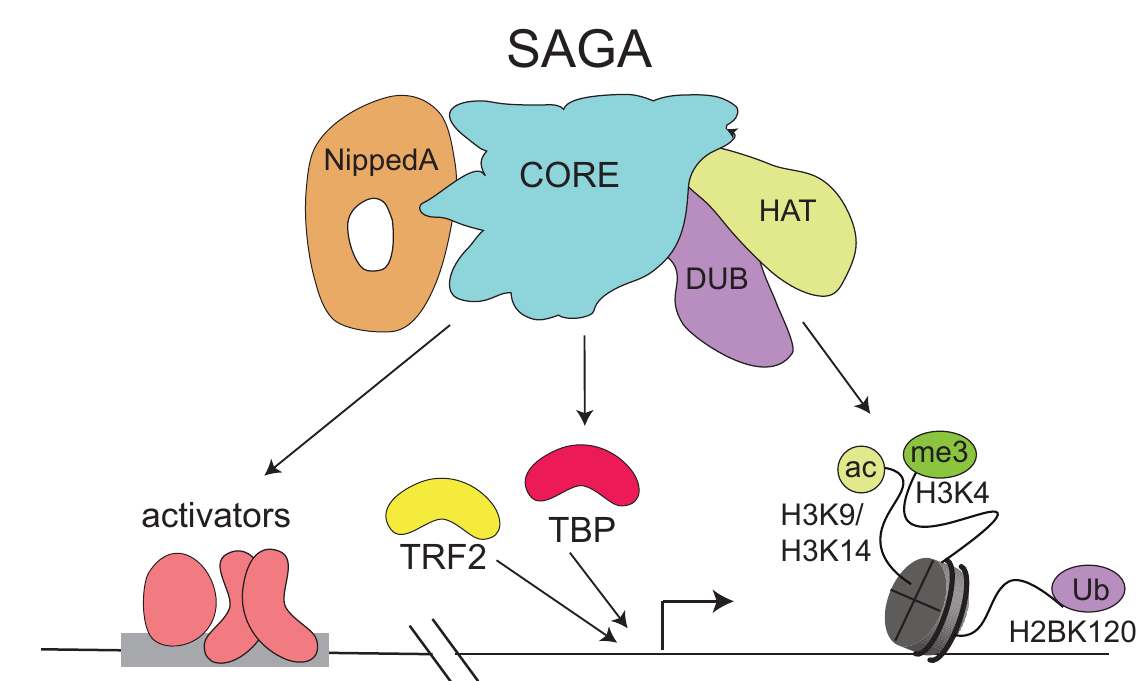
Fig 7. Cartoon of SAGA core module functions during oogenesis. The SAGA complex binds upstream and downstream of the TSS at active genes, without discriminating by promoter type. The upstream peak is likely due to interactions of the core module and Nipped A, which interact with activators. The complex is also present at the +1 nucleosome, where it can read H2bUb, H3K4me3 and H3K9/4ac and is retained. After its recruitment to the +1 nucleosome, the enzymatic DUB and HAT activities of SAGA retain the complex, carryout histone modifications and may help maintain the core promoter region in an open state, while the core module may contribute to deposition of TBP onto the core promoter. We speculate that through its capacity to interact with TBP, the SAGA core module may help to increase the concentration of TBP near promoter